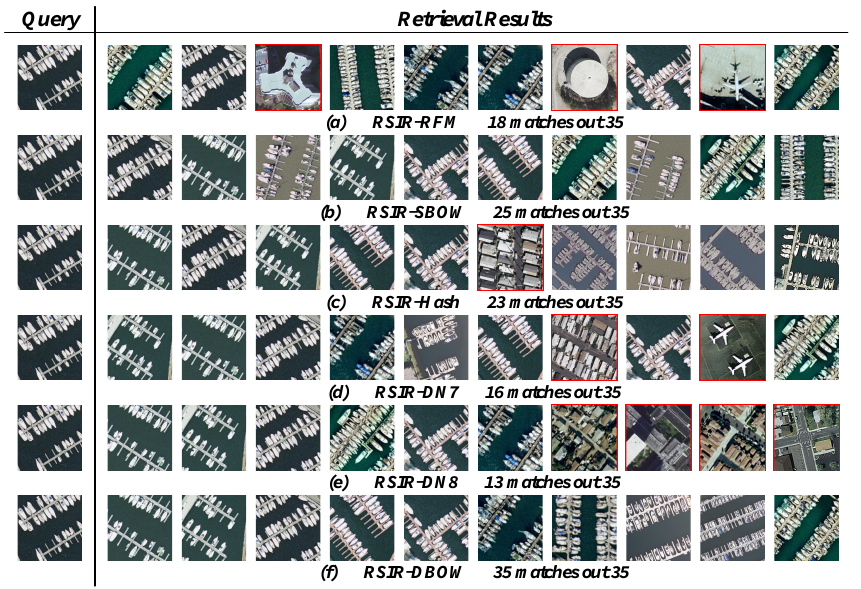
Figure 19. Retrieval examples of “Harbor” within ImgDB1 using different RSIR methods. The first images on the left in each row are the queries. The rest of the images in each row are the top 10 retrieval results. The incorrect results are tagged in red, and the number of correct results among the top 35 retrieval images is also provided.